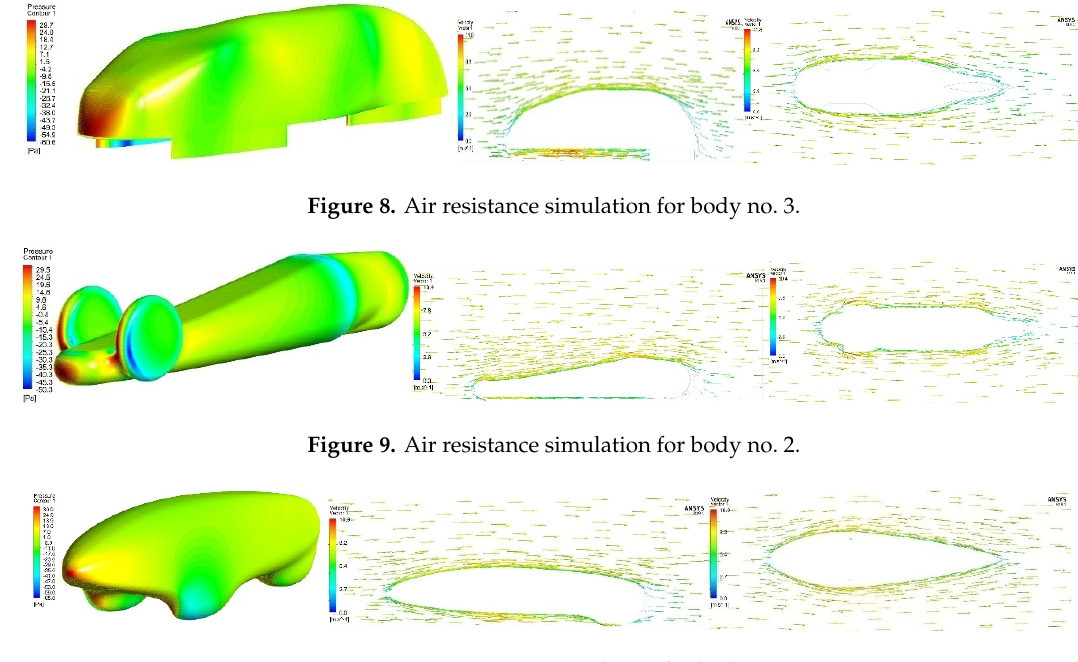
Figure 10. Air resistance simulation for body no. 1.